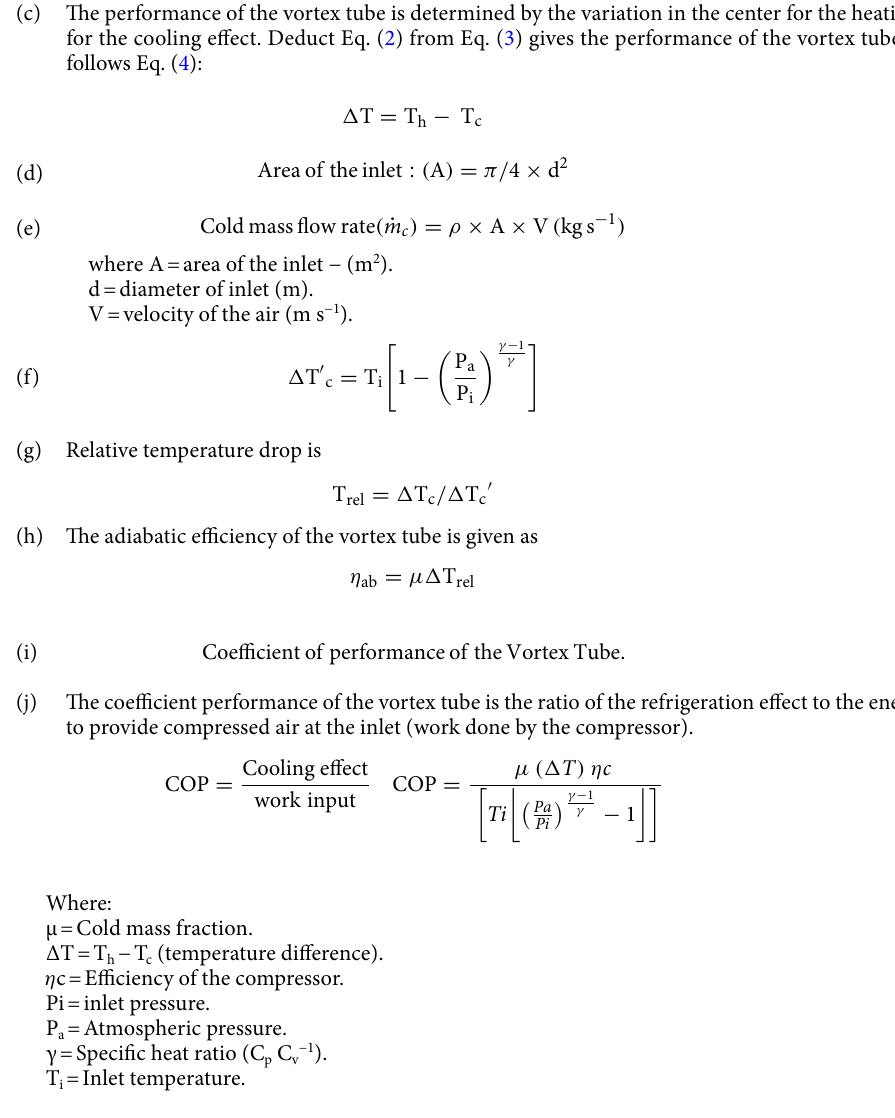
Figure 3 related to stainless steel vortex tube with an inlet pressure of 2 bar. The inlet temperature of the VT is 303 K. The hot air temperature was obtained at the hot end as 306.12 K. Similarly at cold end side obtained a value of 301.47 K. The maximum temperature difference was found to be 4.67 K. Figure 4 related to the brass vortex tube with an inlet pressure of 2 bar. The inlet temperature of the VT is Figure 5 represented to PVC vortex tube with an inlet pressure of 2 bar. The inlet temperature of the VT is 303 K. The hot air temperature was obtained at the hot end as 304.46 K, and at the cold end side obtained a value